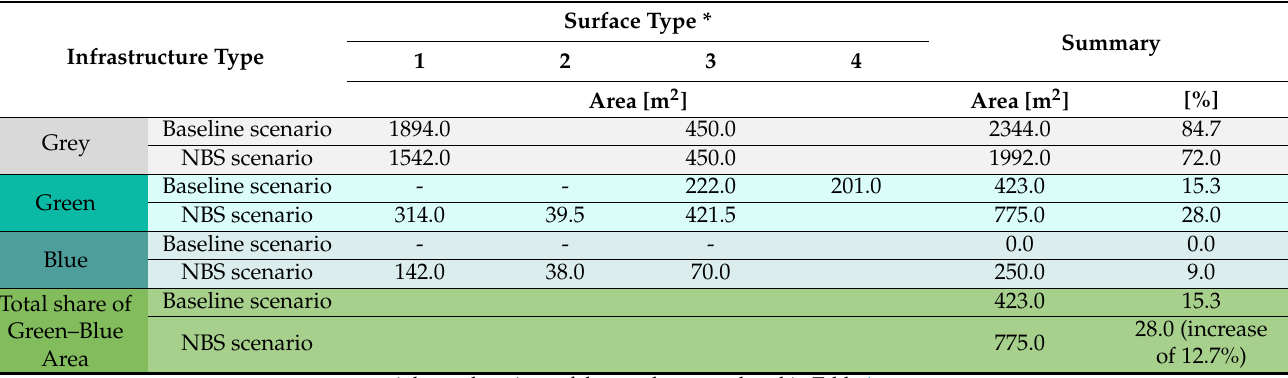
Table 7. Area balance by type of grey–green–blue infrastructure.